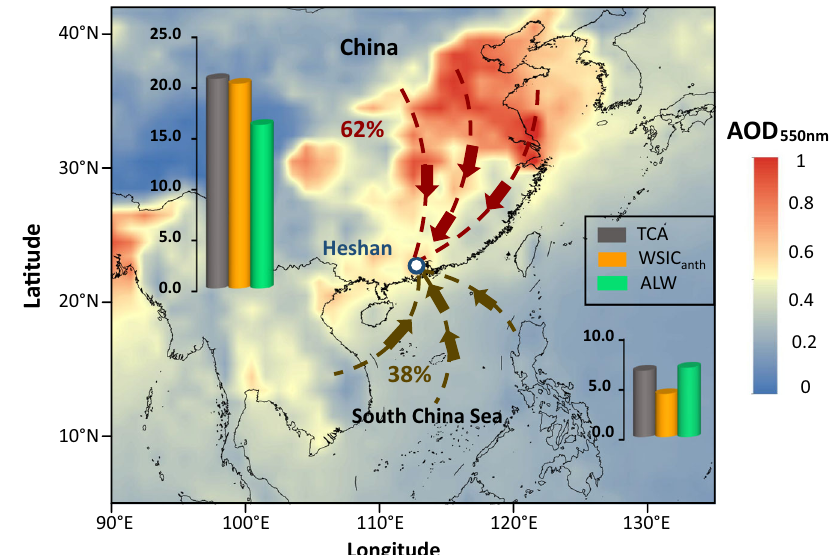
Fig. 1 | Meteorology and general aerosol chemical characteristics of the study site(Heshancity). Theaverageaerosolopticaldepth(AOD)at550nmduringJune 2017 to May 2018 over the East Asia region are shown. The mean air mass back trajectories (BT) based on HYSPLIT cluster analysis show two dominant air mass transportpathways (dashed line and arrows):continental out fl ow (62%of the total clusters)andoceanicairmasses(38%oftotalclusters).SeeSupplementaryFig.2for the 72-h BT with a 6-h interval and Supplementary Fig. 3 for relative cluster con- tribution. The bar charts depict the mass concentrations of total carbonaceous